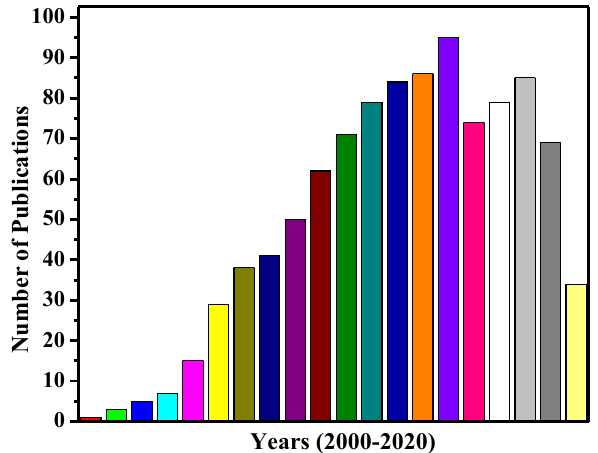
Fig. 1. Year wise statistics for the colorimetric detection of Hg 2+ ion using functionalized AuNPs (2000-2020, Left to